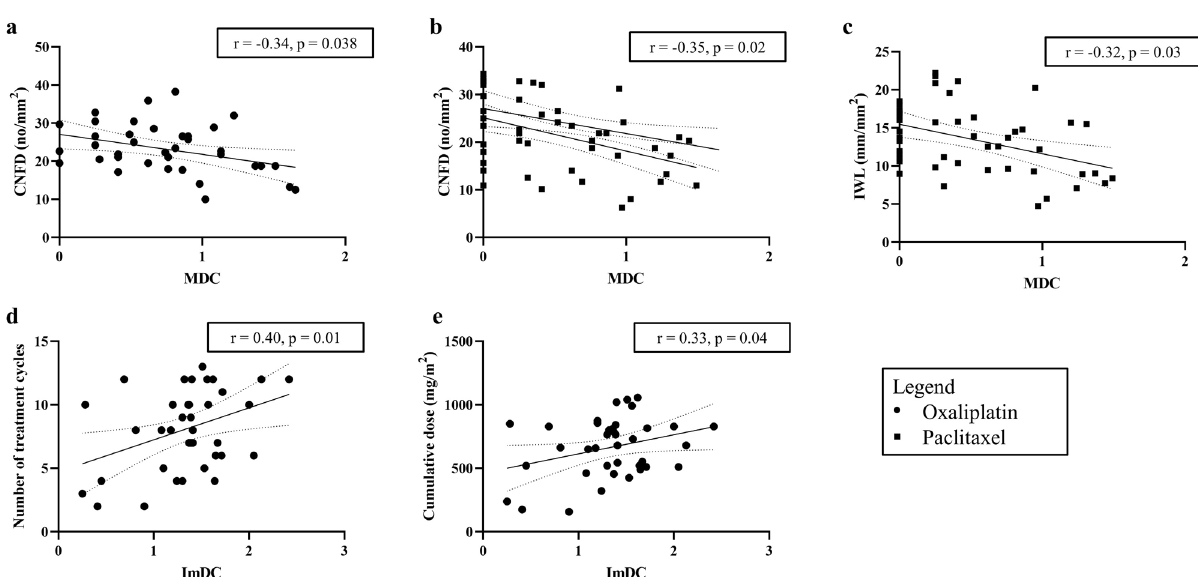
Figure 3. Dendritic cell density correlations. Scatterplots with linear regression and 95% confidence interval bands showing association between log values of higher mature dendritic cell density (MDC) and loss of corneal nerve fiber density (CNFD) in ( a ) oxaliplatin-treated patients and ( b ) paclitaxel-treated patients. Correlation between MDC and loss of inferior whorl length (IWL) in paclitaxel-treated patients is shown in ( c ). Increased immature dendritic cell density (ImDC) in oxaliplatin-treated patients was associated with ( d ) higher numbers of treatment cycles associated and ( e ) higher cumulative dose of Both CNFD and CNFL were reduced in the oxaliplatin (CNFD: 23.2 ± 6.3 no/mm 2 , p = 0.01; CNFL: